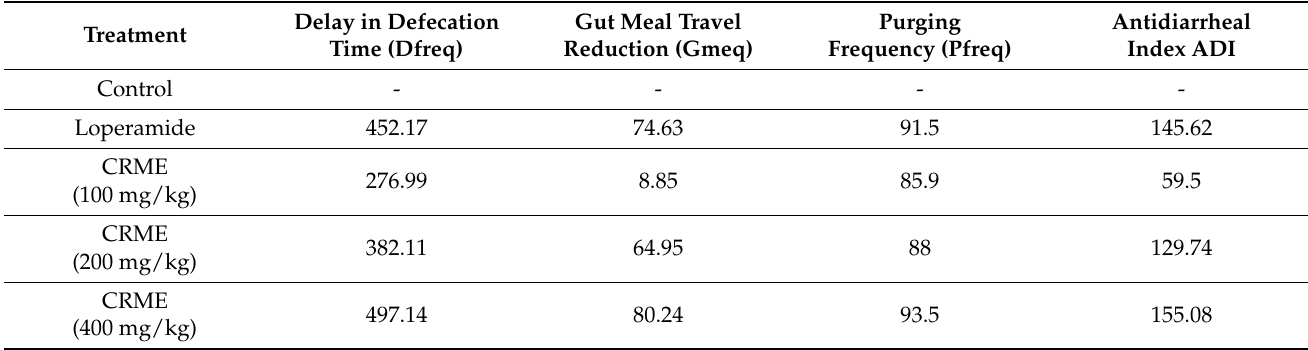
Table 8. The in vivo antidiarrheal index of